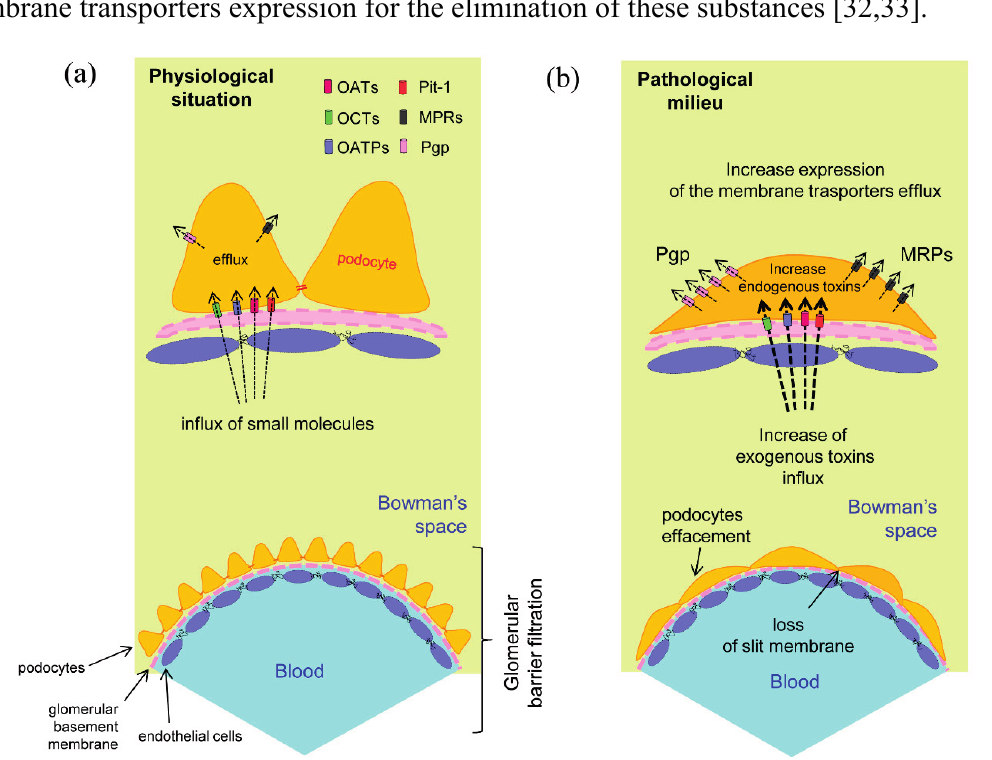
Figure 2. Podocytes membrane transporters. ( a ) Expression and hypothetical localization in physiological conditions. The membrane transporters regulate the influx and efflux of the specific compounds helping to maintain cellular integrity; ( b ) In the pathological situation the foot processes effacement may correlate to the increased input of toxic exogenous substances or to the appearance of cellular metabolites due to a previous cell damage. The presence of intracellular toxic compounds could promote the raise of efflux membrane transporters expression for the elimination of these substances